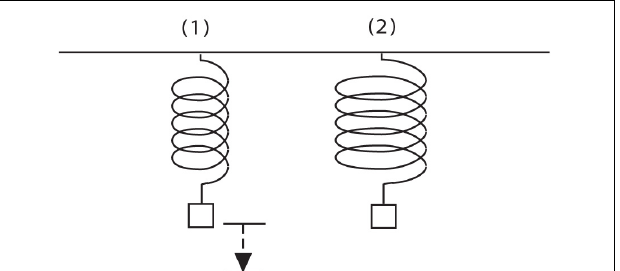
FIGURE 2 | Spring problem. A weight is hung on a spring. The original spring is replaced with a spring made of the same kind of wire, with the same number of coils, but with coils that are twice as wide in diameter. Will the spring stretch from its natural length more, less, or the same amount under the same weight? (Assume the mass of the spring is negligible). Why do you think so? (Reprinted with permission from Clement, 2008, p.